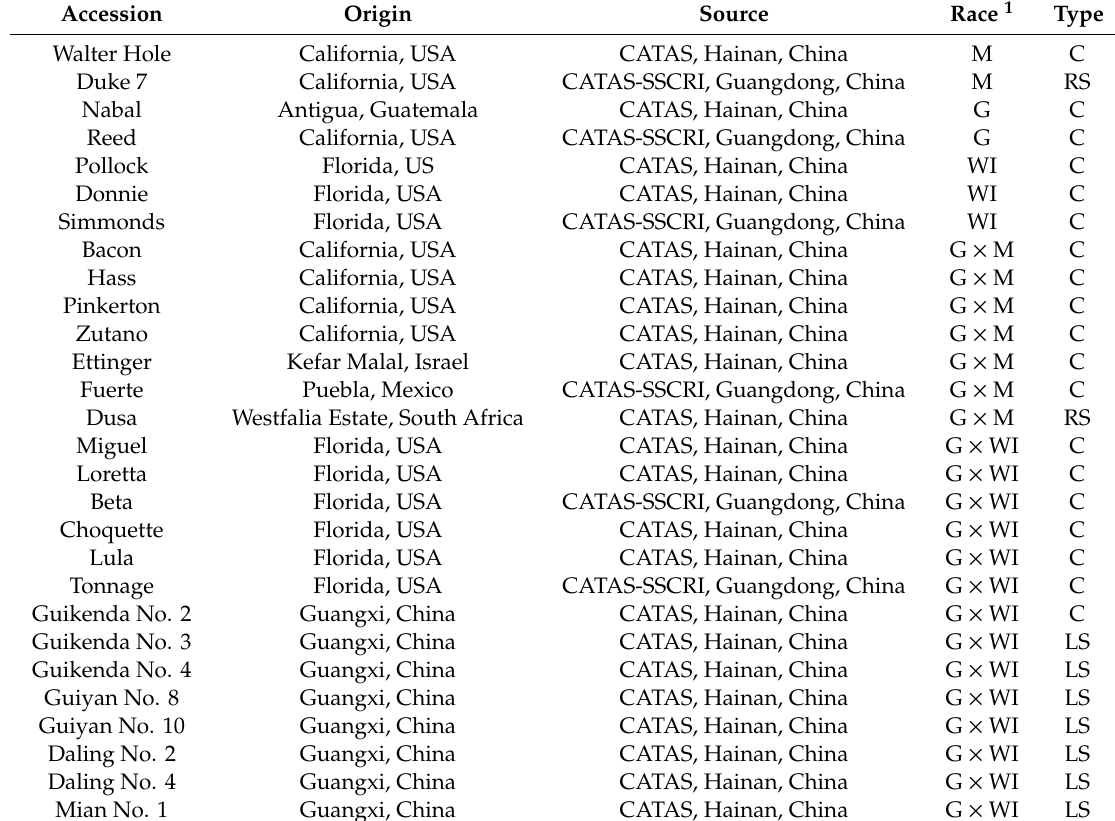
Table 1. Sources of the 28 avocado accessions evaluated in this